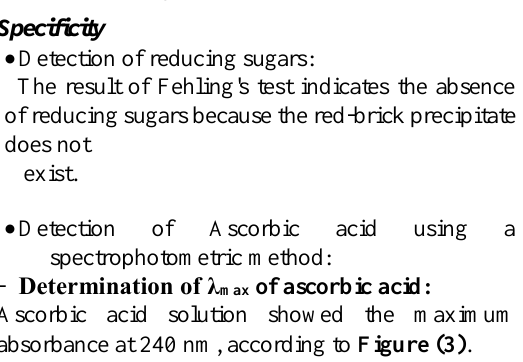
Figure 2. TPC in 1 g of the dried extracts All results of TPC are presented as the mean of three replicates ± SD ( p < 0.05)